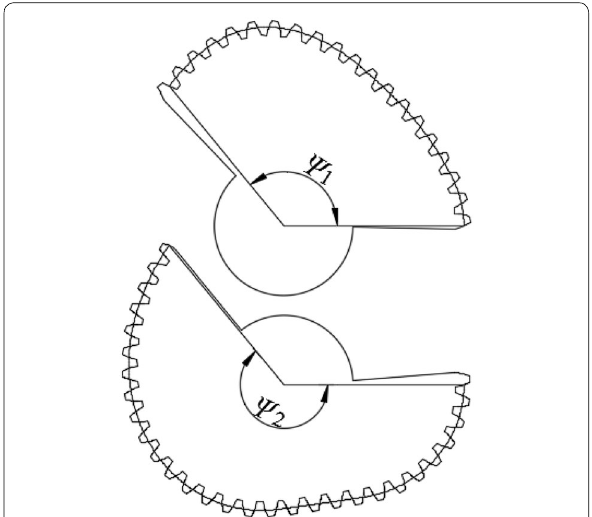
Figure 2 Central angle of the two driving